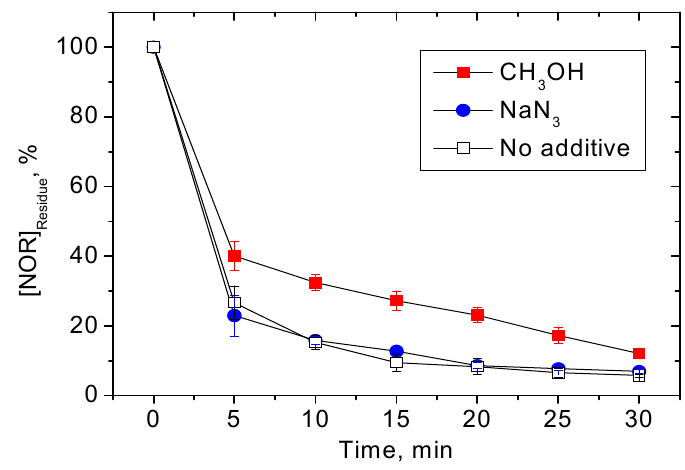
Figure 6. Degradation of NOR by the MW/UV process using different scavenging agents. (Experimental conditions: microwave power = 500 W, UV light intensity = 31.8 mW/cm 2 , maximum wavelength = 254 nm, [NOR] = 5 mg/L, [CH 3 OH] = 5 mg/L, [NaN 3 ] = 5 mg/L).